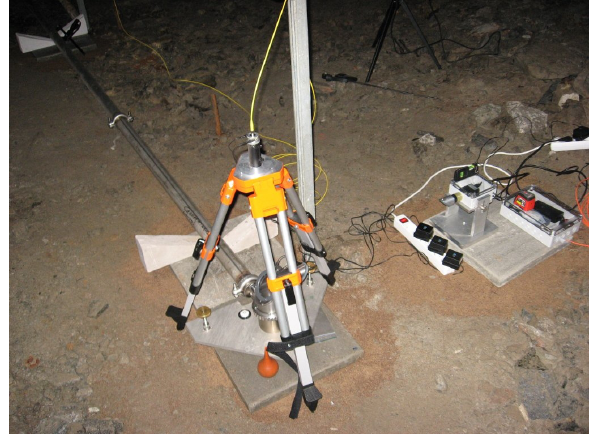
Figure 1: Northern end of the NSWT tilt meter. (Photo: Hannu Ruot- salainen).